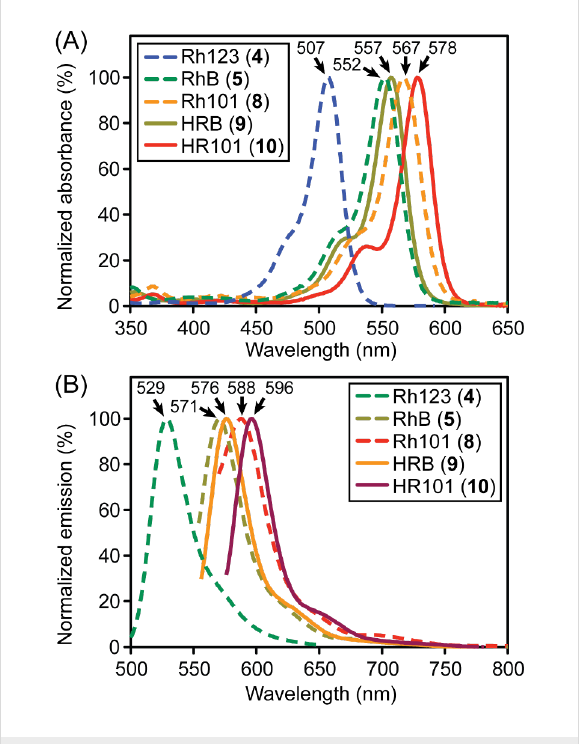
Figure 2: Normalized absorbance (Panel A) and fluorescence emis- sion (Panel B) spectra. Fluorophores were analyzed at 10 µM (absorbance) or 5 nM (fluorescence) in MeOH. The spectra for rhodamine 123 ( 4 ) in MeOH were downloaded from a publically acces- sible database [41]. Maximum absorbance and emission wavelengths are indicated with arrows.